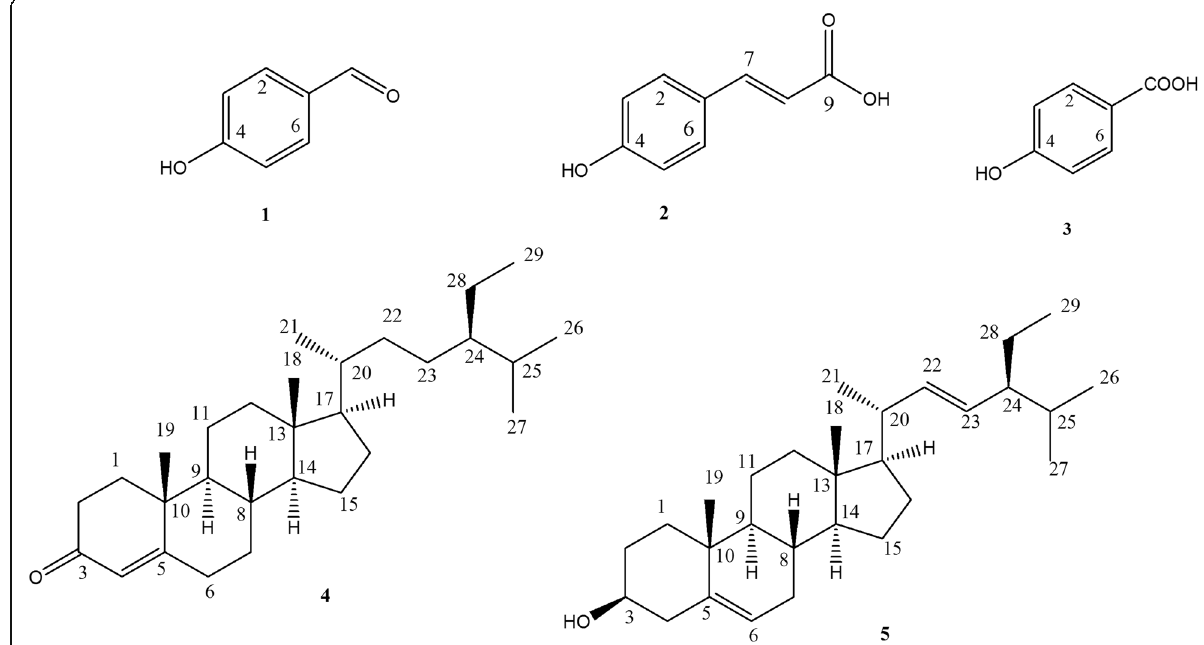
Fig. 1 Structures of 4-hydroxybenzaldehyde ( 1 ), 4-hydroxycinnamic acid ( 2 ), 4-hydroxybenzoic acid ( 3 ), stigmast-4-en-3-one ( 4 ) and β - stigmasterol ( 5